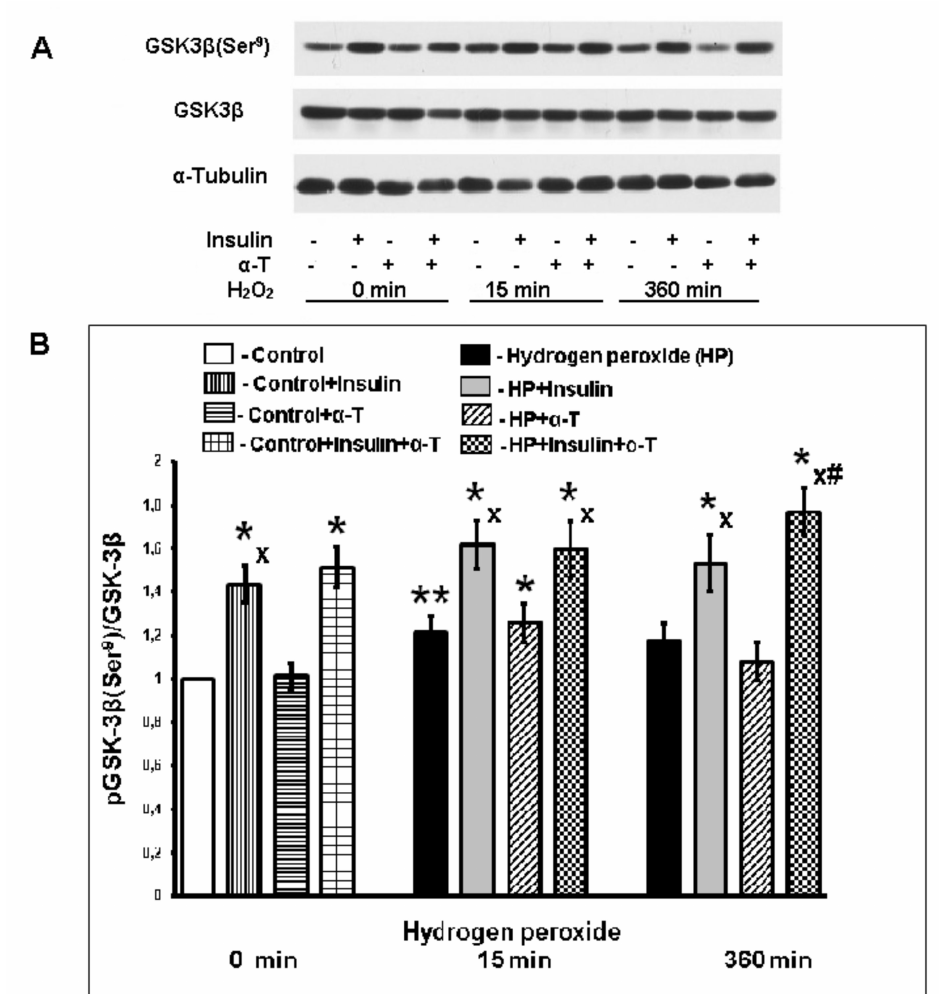
Figure 5. The effect of hydrogen peroxide, insulin and α -T on the activity of protein kinase GSK-3beta [pGSK-3beta (Ser 9 )/GSK-3beta] in brain cortical neurons. ( A ) immunoblots of pGSK-3beta (Ser 9 ) and total GSK-3beta are shown; ( B ) the data of 10 experiments are presented as the means ± SEM. The brain cortical neurons were pre-incubated for 1 h with 1 µ M insulin or for 18 h with 50 µ M α -T or with both drugs or without them. Then the neurons were exposed to 100 µ M hydrogen peroxide for 0, 15 and 360 min. The differences are significant according to Student’s paired t -test as compared: * and **—to the control, * p < 0.02, ** p < 0.05; x—to the effect of hydrogen peroxide alone, p < 0.01, #—to the effect of insulin or α -T alone, p <